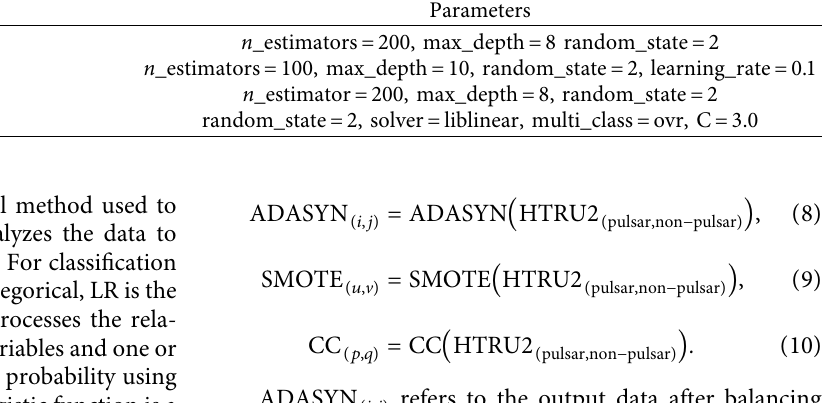
Table 5: Hyperparameters for machine learning models. Algorithms